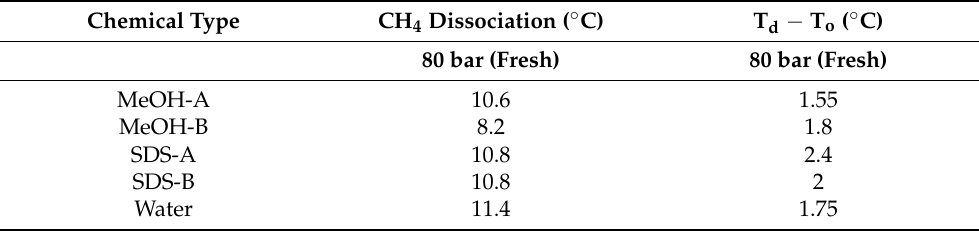
Table 2. Information on dissociation temperature T d (°C) in the presence of MeOH, SDS, and water under 80 bar. T d –T o (°C) indicates the difference between dissociation temperature (T d ) and onset nucleation temperature (T o ).